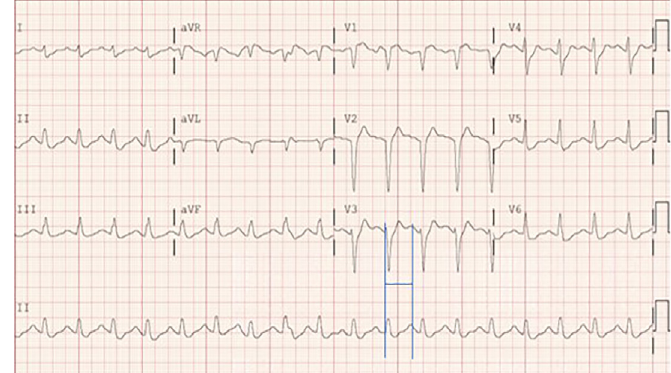
Image 4. Sinus tachycardia and prolonged QTcFri interval 491 milliseconds in a patient who ingested chloroquine phosphate aquarium